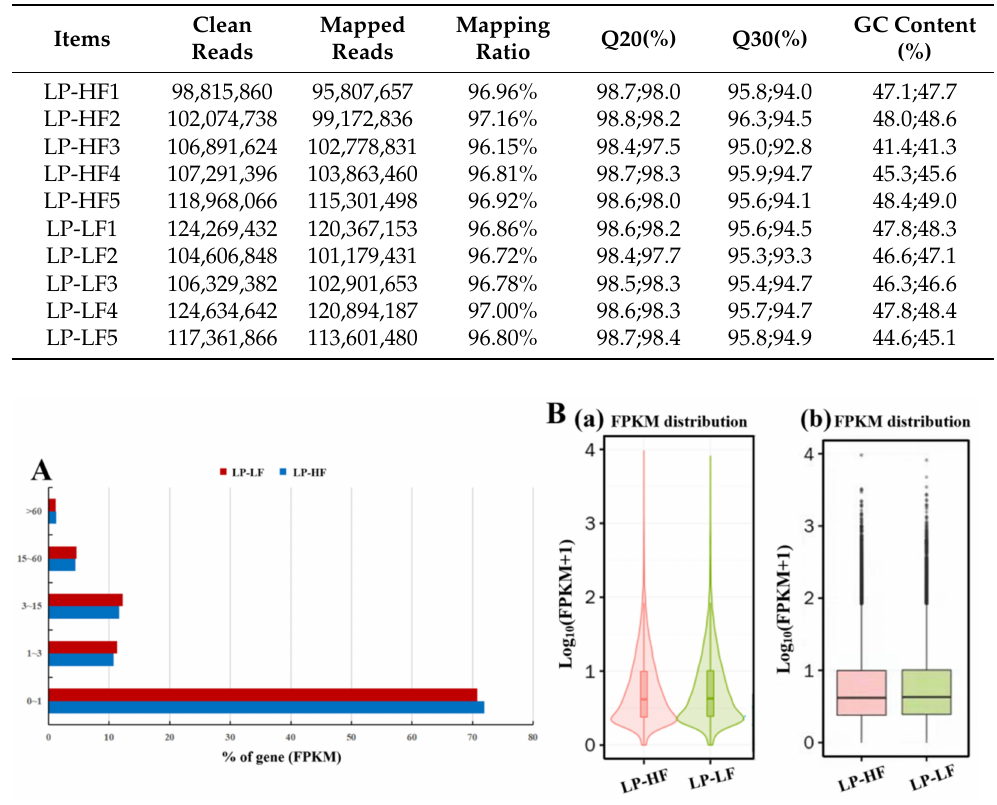
Figure 2. FPKM ( A ) distribution of the identified genes and violin ( a ), box plots ( b ) of the distribution of the FPKM expression levels ( B ) across all transcripts under the LP-HF and LP-LF comparisons. The width of each violin graph reflects the number of transcripts at that expression